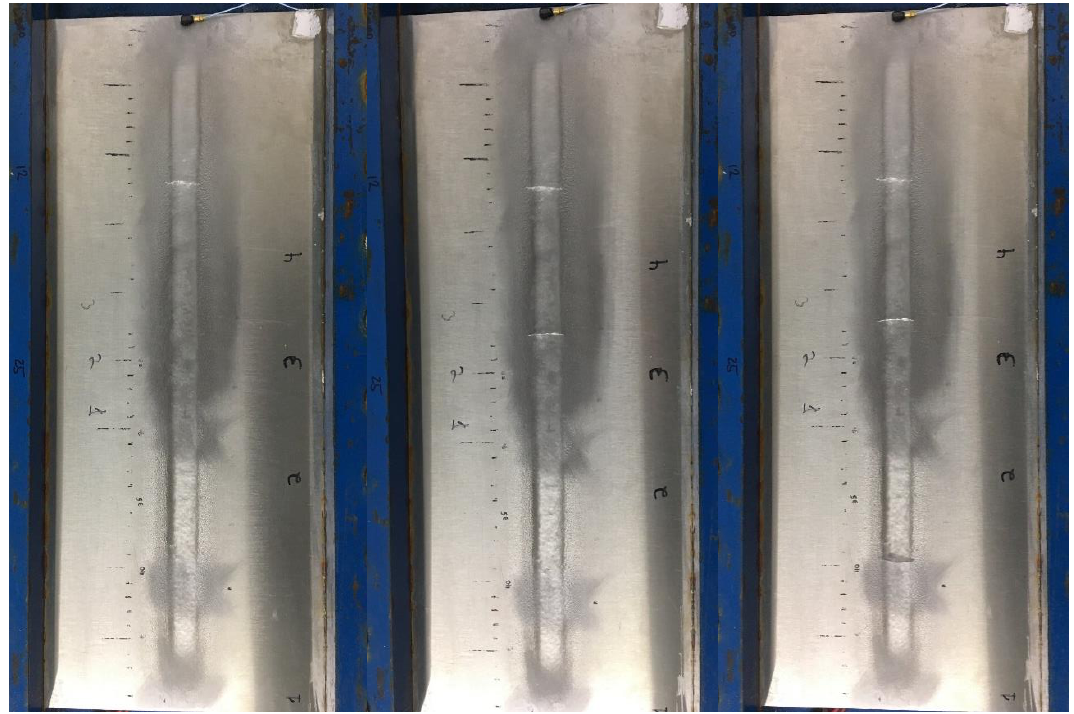
Figure 17. Cracking of the ice layer in steady-state mode at 438 Hz and 300 Vpp ( left ), 426 Hz and 336 Vpp ( middle ) and 418 Hz and 380 Vpp ( right ). Vpp ( middle ) and 418 Hz and 380 Vpp ( right ). Aerospace 2020 , 7 , x FOR PEER REVIEW